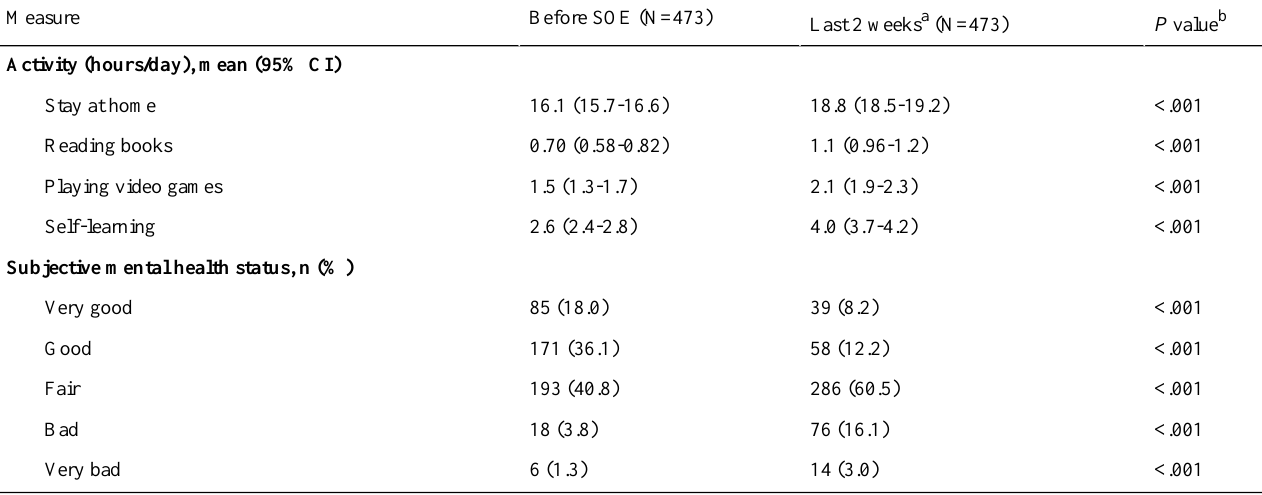
Table 3. Comparison of age-weighted self-learning and related activity times of medical students before and after the national state of emergency (SOE) in